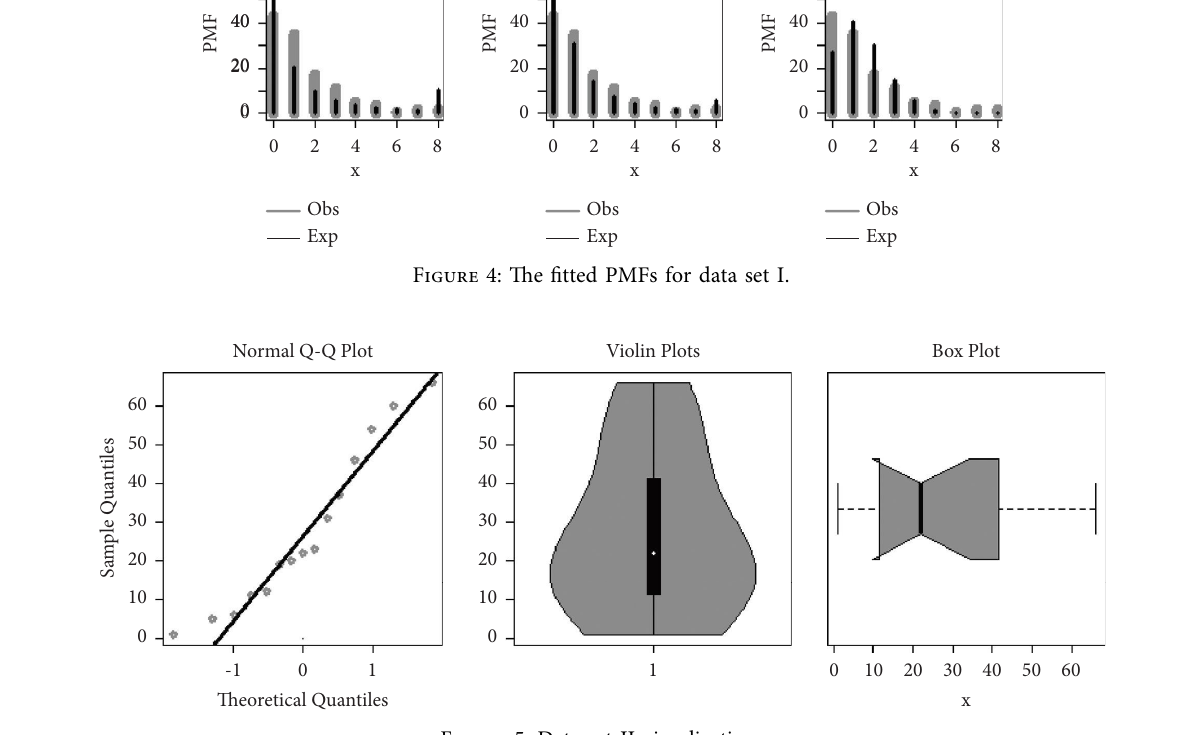
Figure 5: Data set II visualization. Table 11: Te MLE, SE, and CI of the tested models based on data set